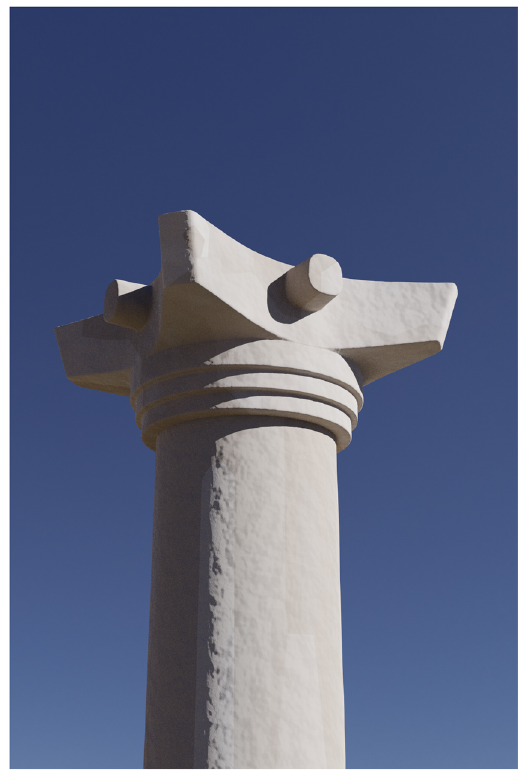
Figure 6: Blocked - out capital from Berenike trench BE19 - 122, artistic reconstruction ( render: S. Pop ł awski )